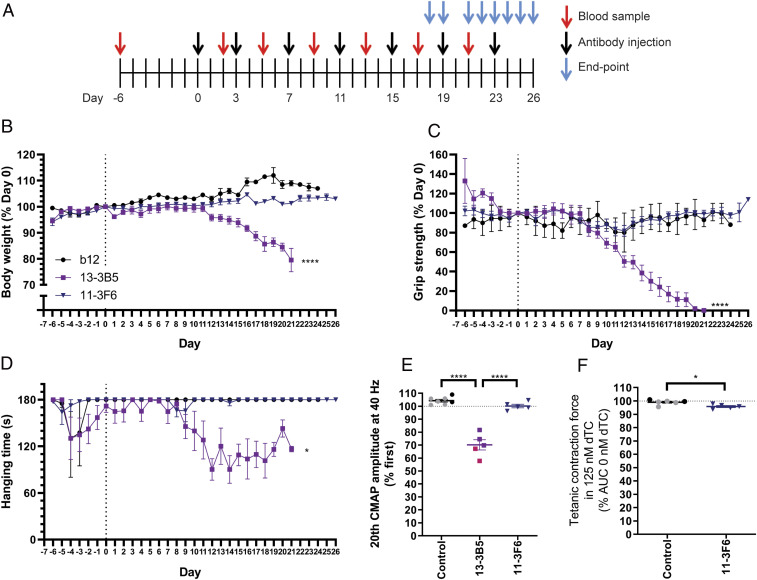
Antibody-dependent pathogenicity of bivalent MuSK antibodies. (A) Experimental design of passive transfer in NOD/SCID mice. Mice exposed to bivalent 13–3B5 started to (progressively) lose weight (B), grip strength (C), and hanging time on the inverted mesh (D) in the third and second week of the experiment, respectively. Mice exposed to bivalent 11–3F6 did not show progressive loss on these parameters (B–D). (E) Mice exposed to bivalent 13–3B5 showed a significant ∼30% CMAP decrement at the end point, while bivalent 11–3F6 did not induce a decrement. (F) Contraction force of the diaphragm was significantly, but very mildly (∼3% reduction), affected by 125 nM dTC for mice exposed to bivalent 11–3F6. Data represent mean ± SEM 13–3B5: 5 mg/kg (pink): n = 2; 10 mg/kg (purple): n = 4 (except for hanging time on inverted mesh and EMG: n = 3); 11–3F6: 10 mg/kg: n = 5; b12 (black): n = 2, combined with untreated (gray): n = 5 for CMAP or n = 4 for tetanic contraction).